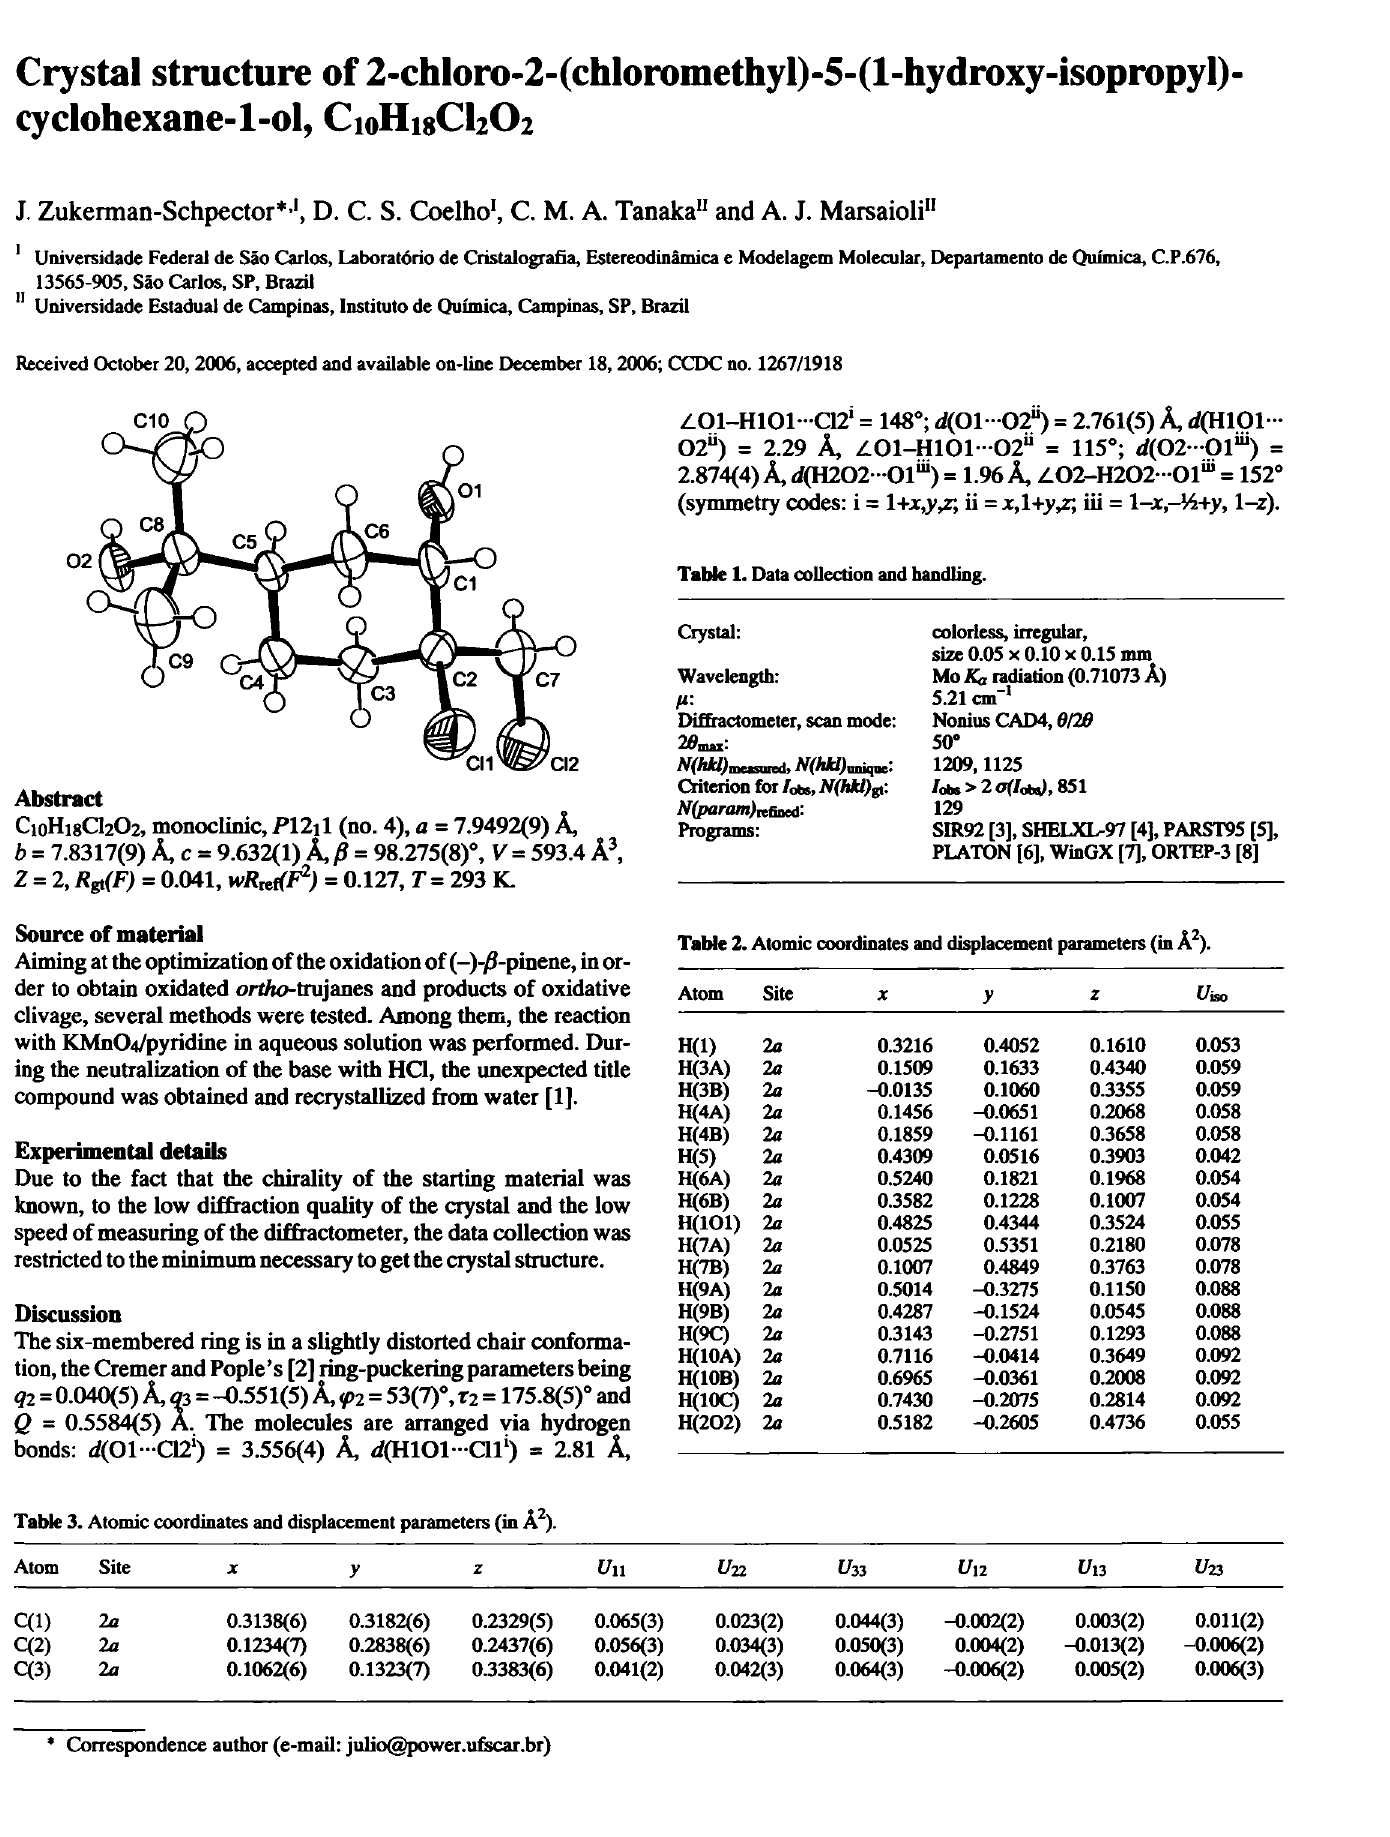
Table 3. Atomic coordinates and displacement parameters (in Ä 2